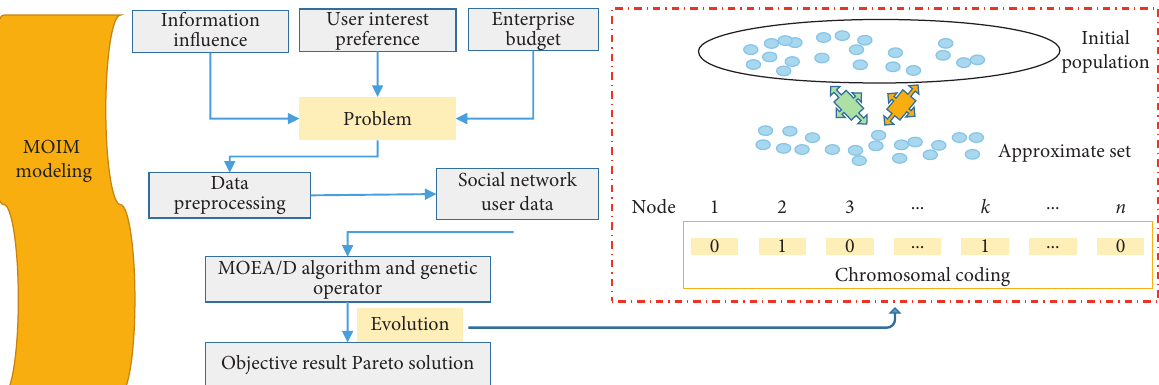
Figure 2: Schematic diagram of the process of multiobjective influence maximization models and